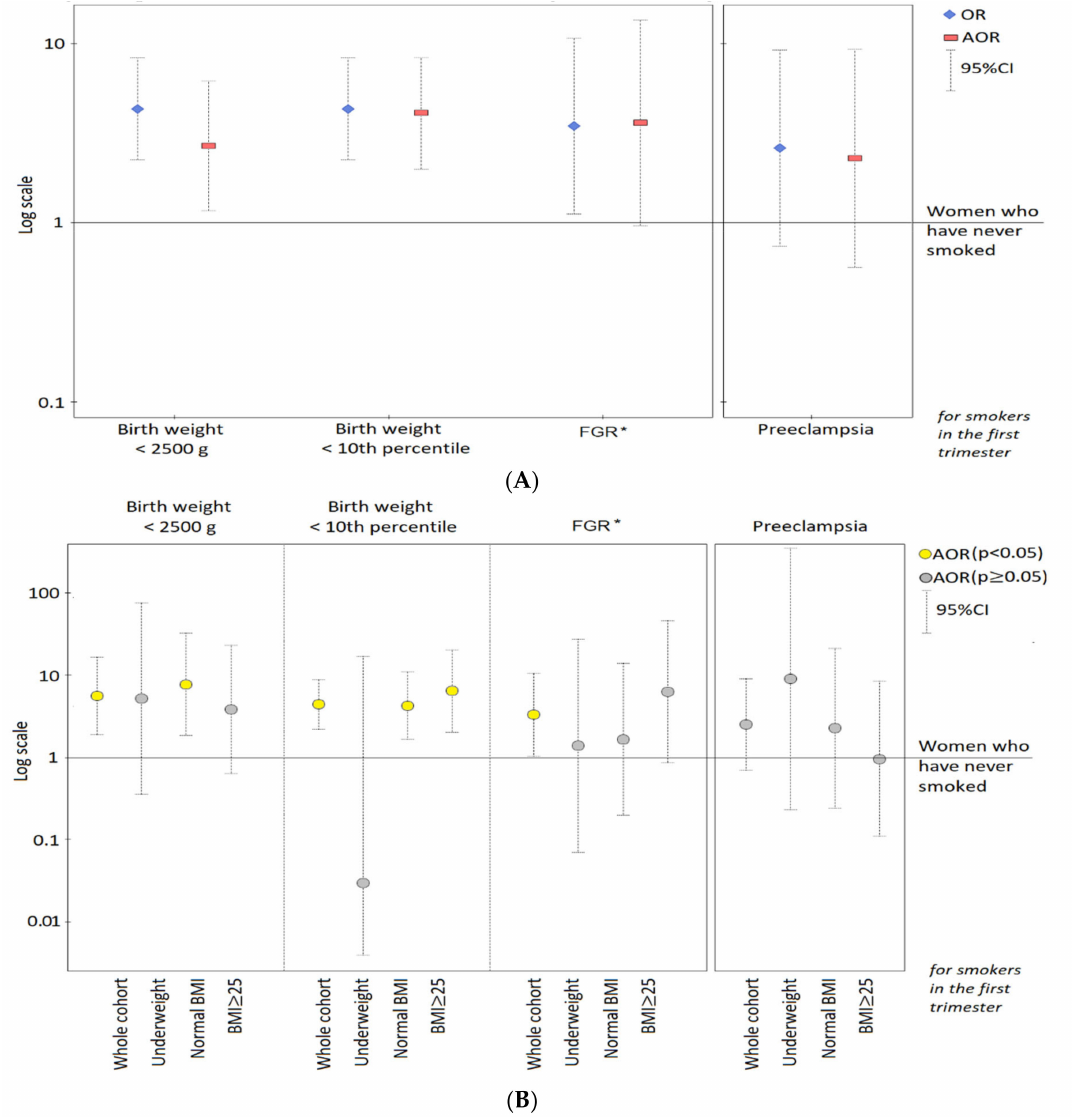
Figure 1. Oddsratios(and95%confidenceintervals)ofnewbornoutcomes(andpreeclampsia)forsmoking in the 1st trimester. The graphs are presented on a logarithmic scale. * FGR: fetal growth restriction. The adjusted odds ratios (AOR) were calculated after adjusting for: ( A ) primiparous women, maternal age, pre-pregnancy BMI as well as GWG outside the range; ( B ) maternal age, height, pre-pregnancy BMI, and gestational age at birth (excluding gestational age in the FGR study, as well as excluding BMI in the BMI categories). The result for LBW in underweight women is